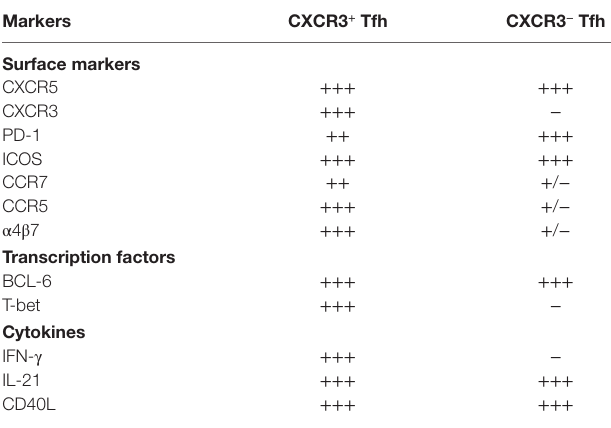
TAbLe 1 | Divergent marker profile of Tfh1 cells versus Tfh0